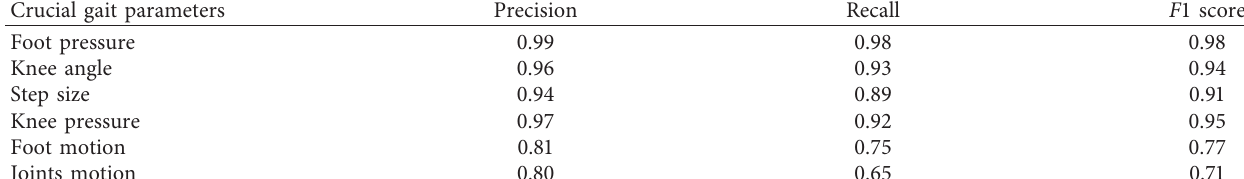
Table 3: F1 score results on crucial gait parameters at the macrolevel validated in real time.